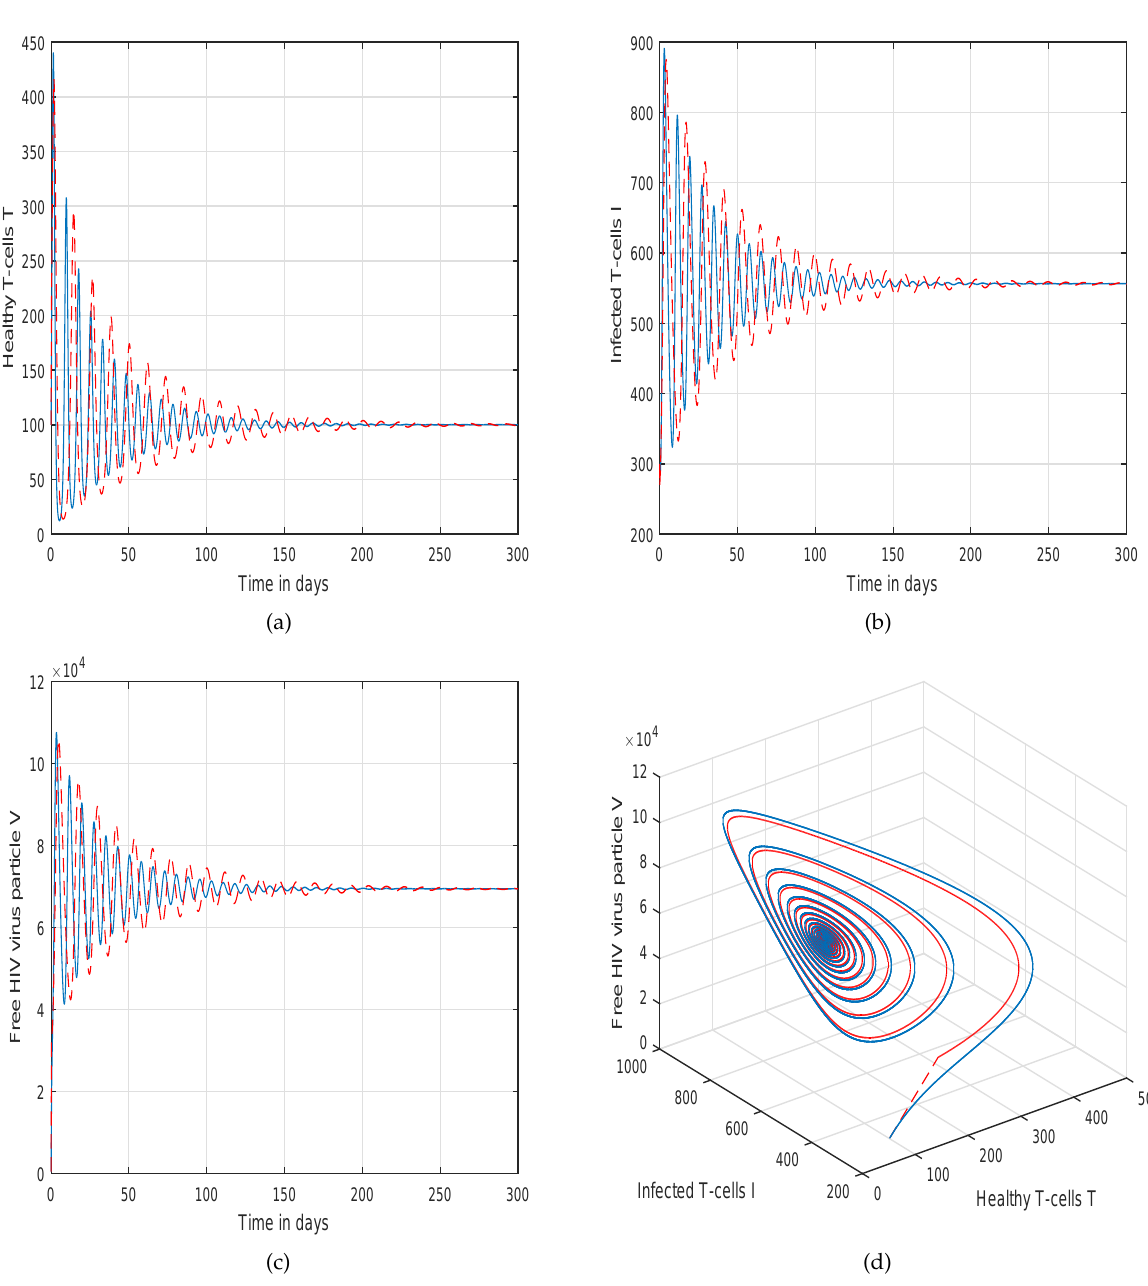
Figure 3. Illustration of the solution pathway of ( a ) healthy CD4 + T-cells, ( b ) infected CD4 + T-cells, ( c ) free HIV virus particles and ( d ) chaotic behavior of the proposed fractional model (2) of HIV infection with fractional-order ϑ =